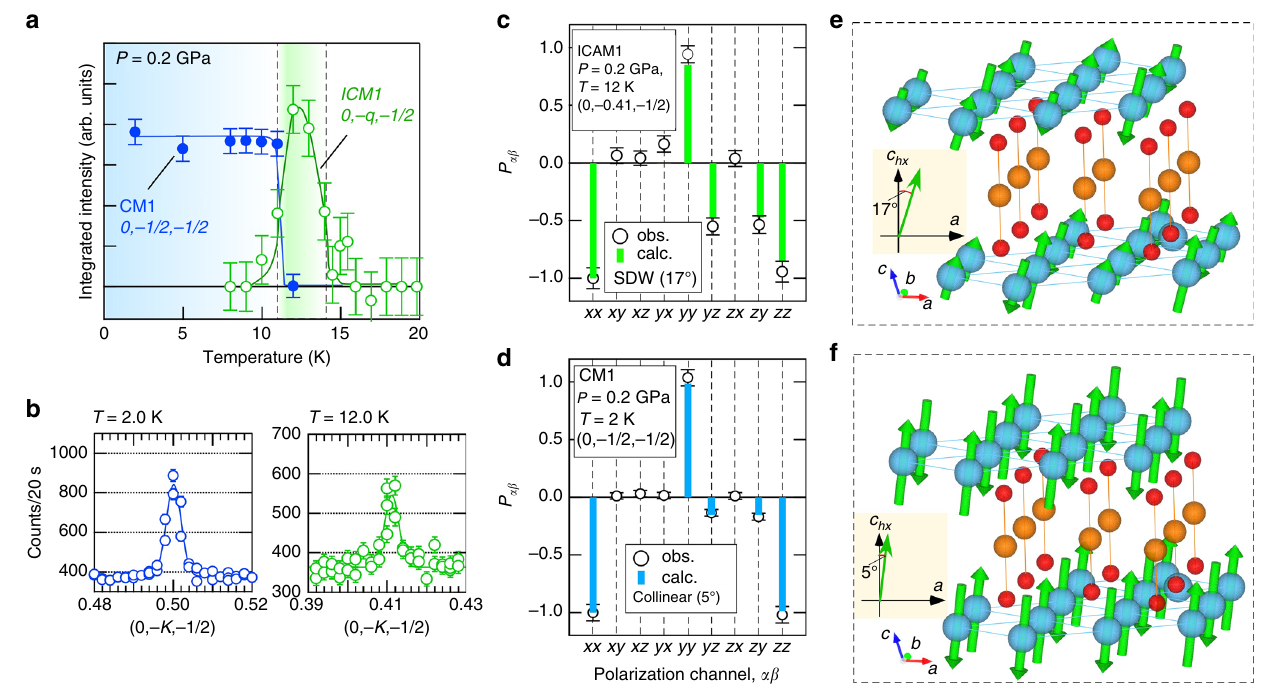
Fig. 2 Spherical neutron polarimetry data at 0.2GPa. a Temperature dependence of the integrated magnetic re fl ection intensities and b typical diffraction pro fi les along the [0, − K , − 1/2] line for the spin fl ip channel in the x -direction at P = 0.2GPa. Comparisons between observed and calculated polarization matrix elements for c the 0, − 0.41, − 1/2 re fl ection at T = 12K in the ICM1 phase and d the 0, − 1/2, -1/2 re fl ection at T = 2K in the CM1 phase at P = 0.2GPa. (The error bars in the intensity, neutron counts, and polarization matrix elements data show statistical errors.) The determined magnetic structures: e a collinear SDW structure with moments canted by 17±2° from the c hx - axis in the ac -plane, and f a collinear commensurate structure with a canting angle of